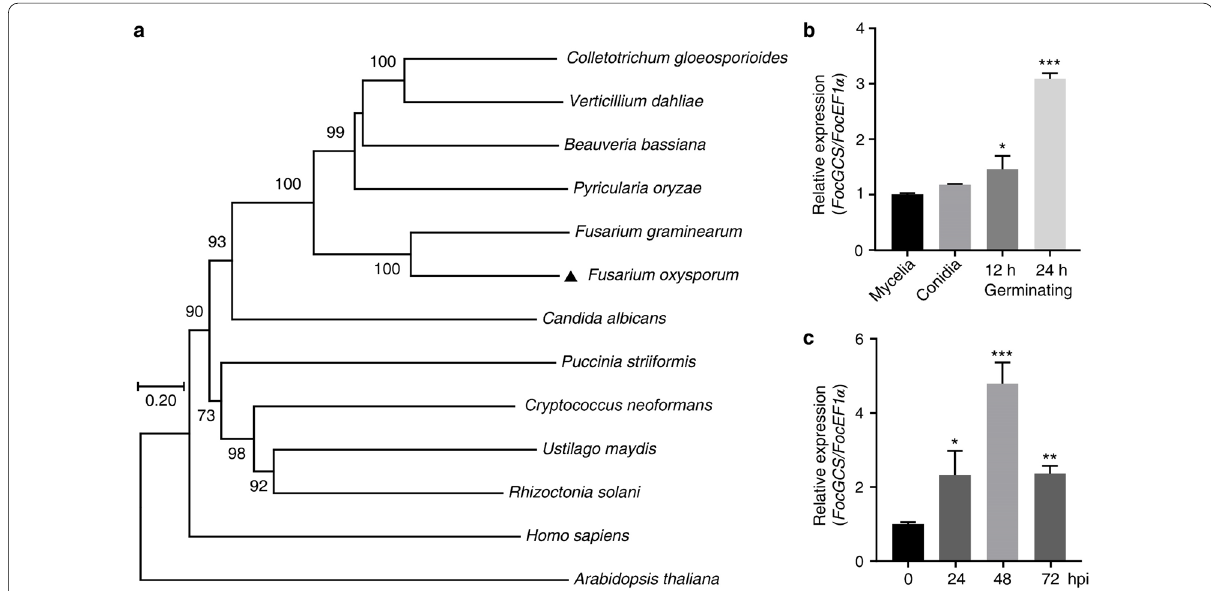
Fig. 1 The expression and phylogenetic analysis of FocGCS . a Phylogenetic tree of putative GCS proteins identified in different organisms. Values on the branches of clusters represent the results of bootstrap analysis (10,000 bootstrap replicates). Verticillium dahliae (XP_009653962.1); Colletotrichum gloeosporioides (EQB52767.1); Beauveria bassiana (KAF1734959.1); Pyricularia oryzae (XP_003710106.1); Fusarium graminearum (XP_011324566.1); Fusarium oxysporum f. sp. cubense tropical race 4 (black triangle, XP_031069237.1); Candida albicans (KGU07664.1); Puccinia striiformis (KNF02135.1); Cryptococcus neoformans (AAX55972.1); Ustilago maydis (XP_011390830.1); Rhizoctonia solani (CUA72326.1); Homo sapiens (NP_003349.1); Arabidopsis thaliana (At2g19880). b Transcript levels of FocGCS at different fungal developmental stages. Asterisks indicate significant difference from the mycelia group (Student’s t ‑test, * P < 0.05, *** P < 0.001). c Transcript levels of FocGCS in infected banana roots. The FocEF1α gene was used as an internal control to normalize the data for comparing the relative transcript abundance. Asterisks indicate significant differences from the control group (Student’s t ‑test, * P < 0.05, ** P < 0.01, and *** P < 0.001). The mean values SD were calculated from three independent ±